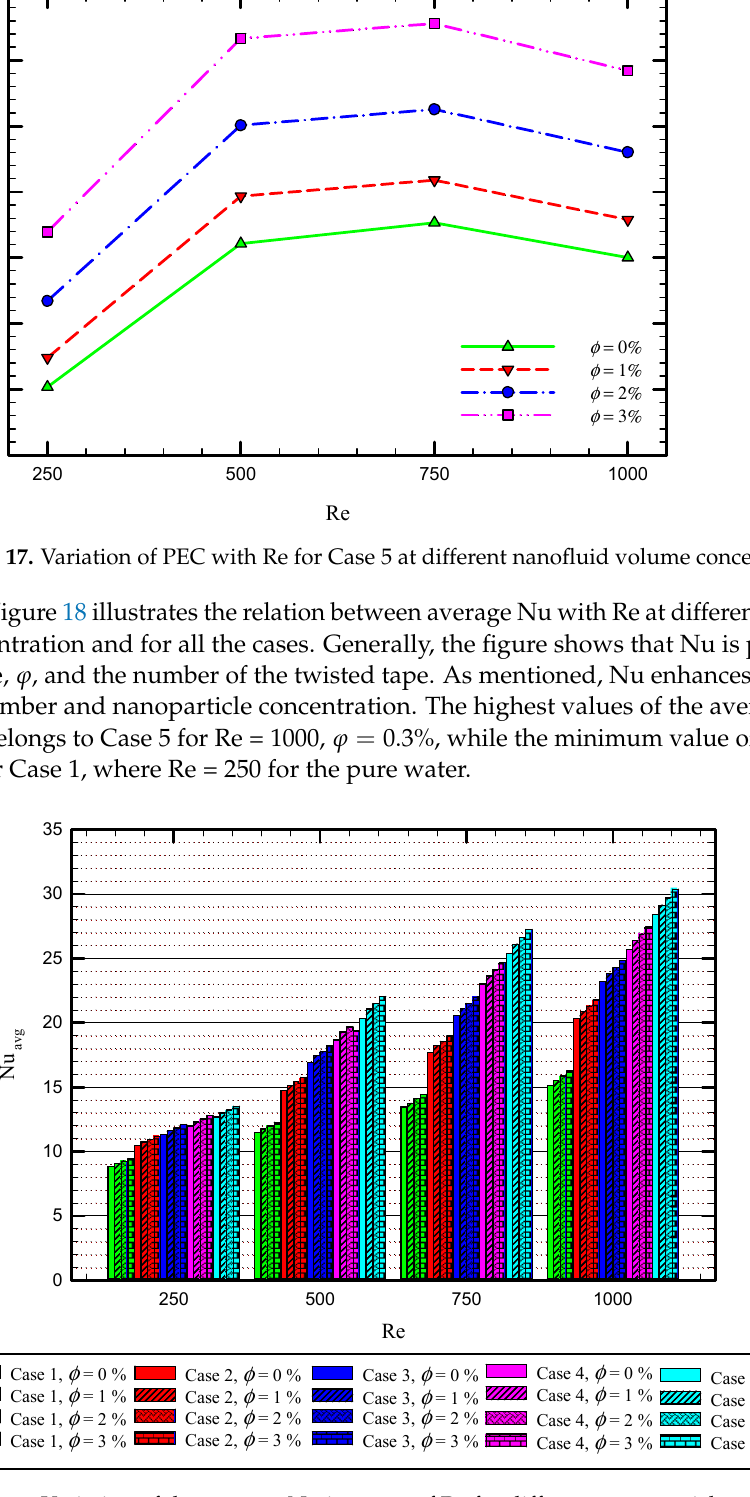
Figure 18. Variation of the average Nu in terms of Re for different nanoparticles concentration for Cases 2, 3, 4, and 5.